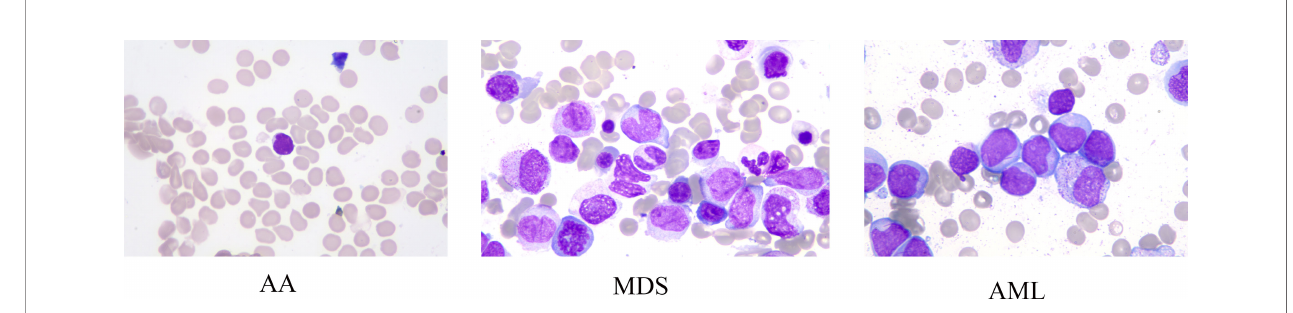
FIGURE 1 | Sample images of aplastic anemia (AA), myelodysplastic syndromes (MDS), and acute myeloid